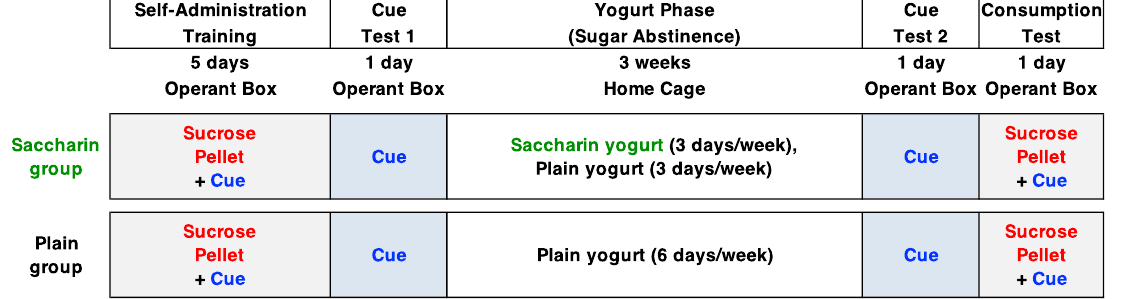
Figure 1. General experimental structure. All subjects received the same training and tests. During the yogurt phase, subjects in the saccharin (SAC) group received plain, unsweetened yogurt for three of the six days each week, and received yogurt sweetened with saccharin for the other three days. Subjects in the plain (PLA) group received plain, unsweetened yogurt for six of the six days each